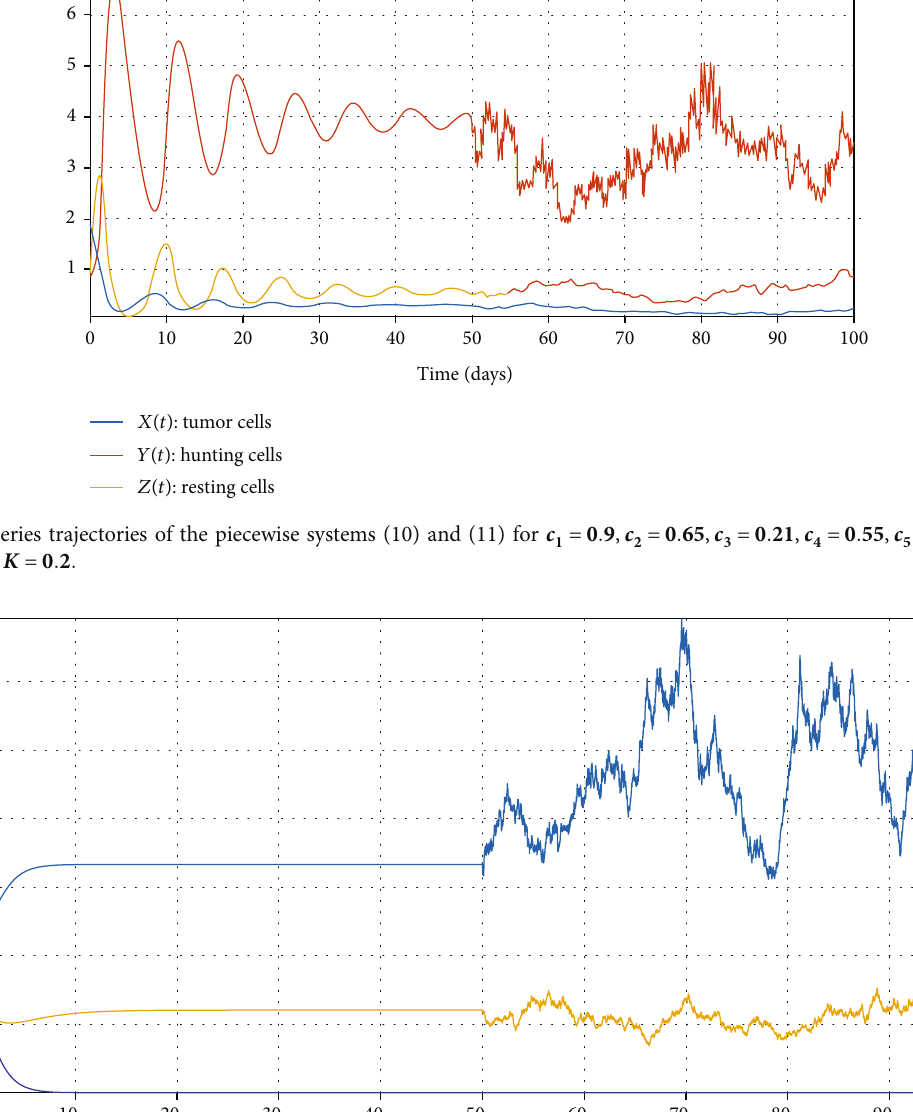
Figure 5: Time series trajectories of the piecewise systems (10) and (11) for c = 0 : 21 , c = 0 , K = 0 : 2 8